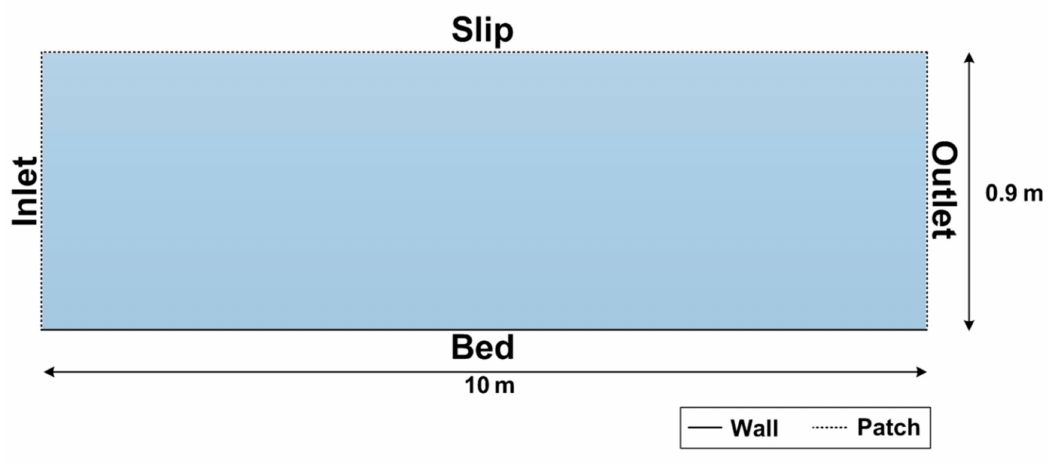
Figure 7. Conceptual outline of the boundary conditions and mesh representing a section of the Trunk Sewer from